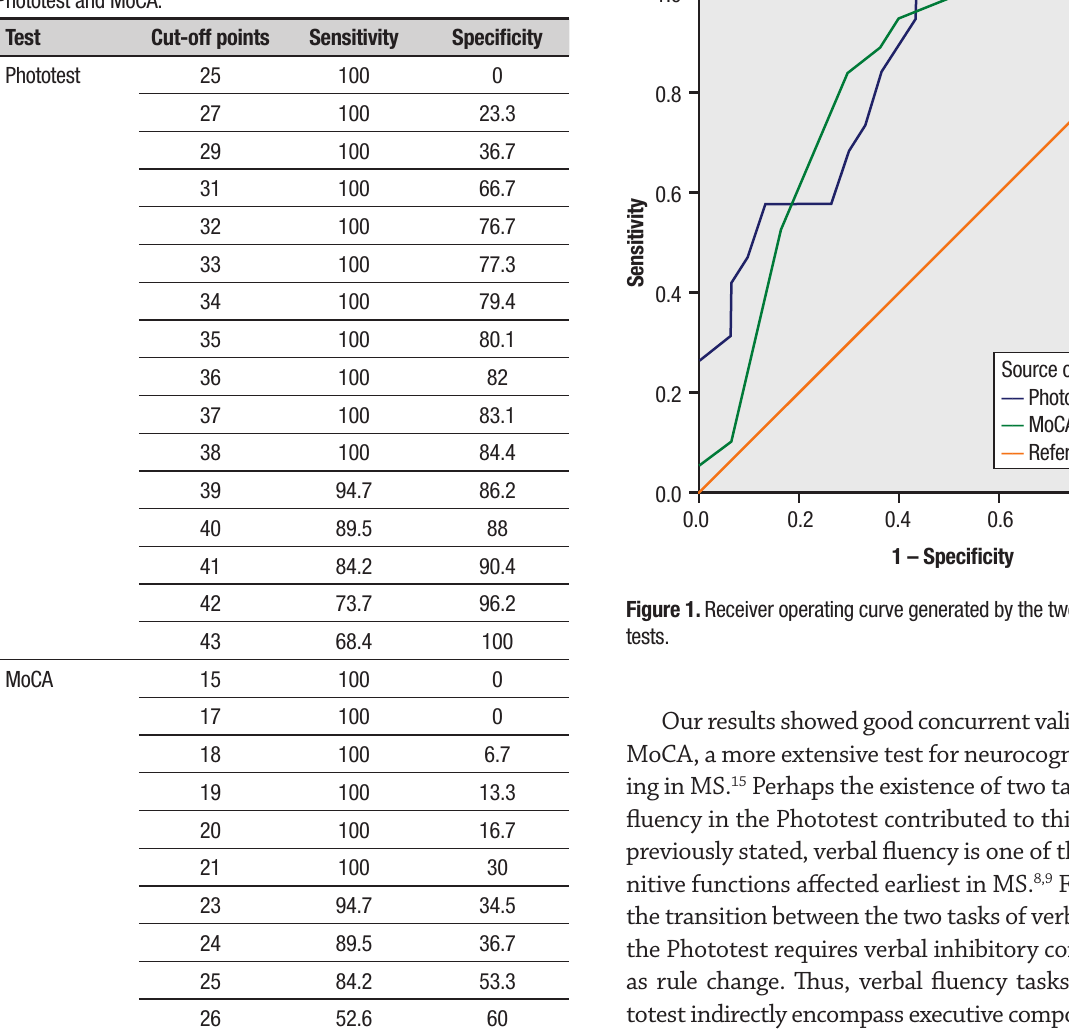
Table 3. Cut-off points and corresponding sensitivity and specificity for Phototest and MoCA.